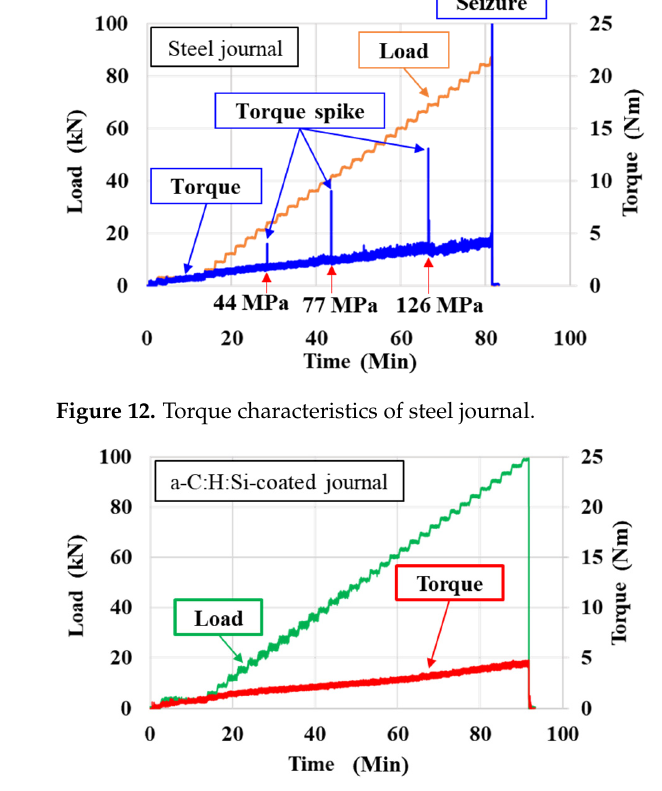
Figure 13. Torque characteristics of a-C:H:Si-coated journal.